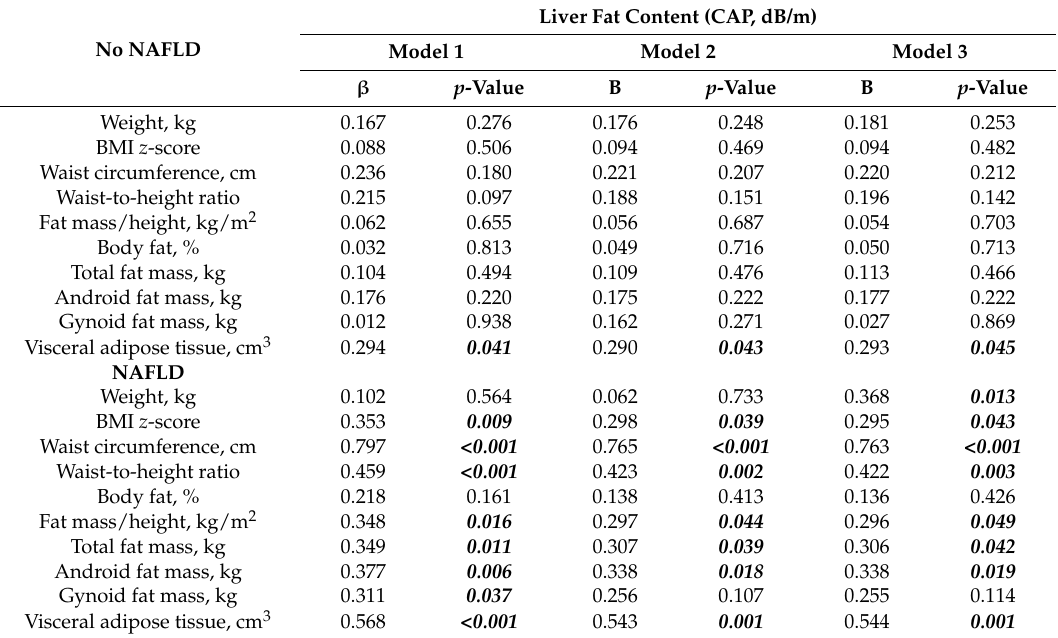
Table 2. Association of liver fat content by controlled attenuation parameter (CAP) on fat distribution parameters in youth with an excess of adiposity according to the presence or absence of NAFLD